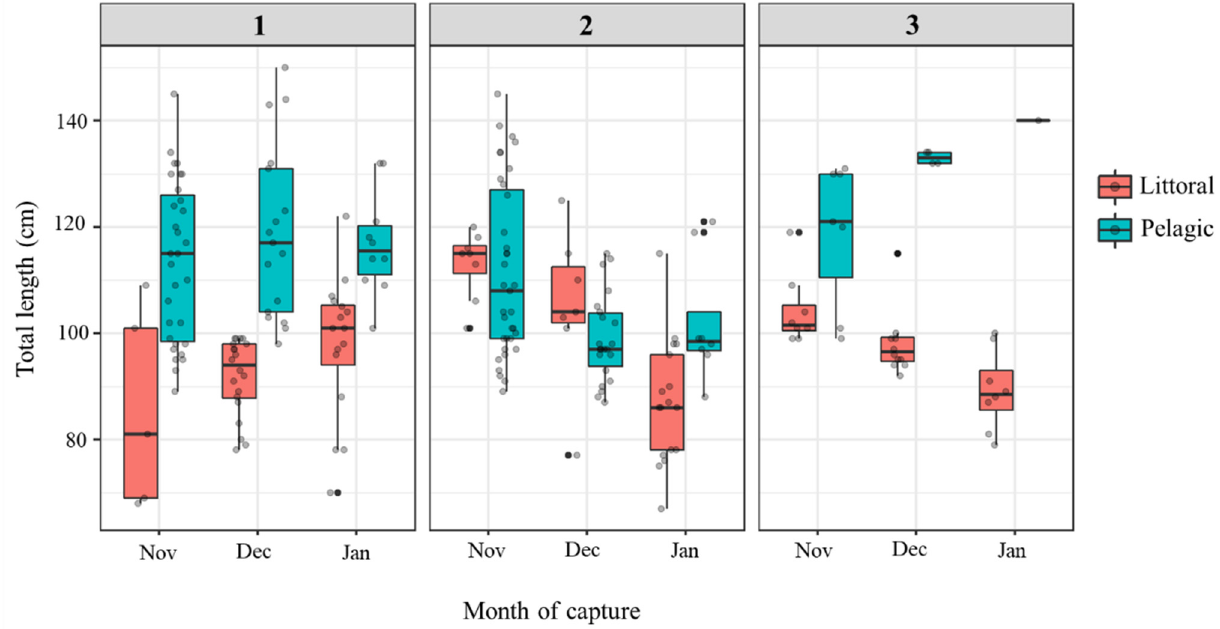
Figure 2. Box and whisker plots of catfish total lengths across sampling month (November 2019 to January 2020) and between pelagic and littoral habitats at each sampling site (Figure 1). Grey points represent each individual catfish, while black points are outliers.